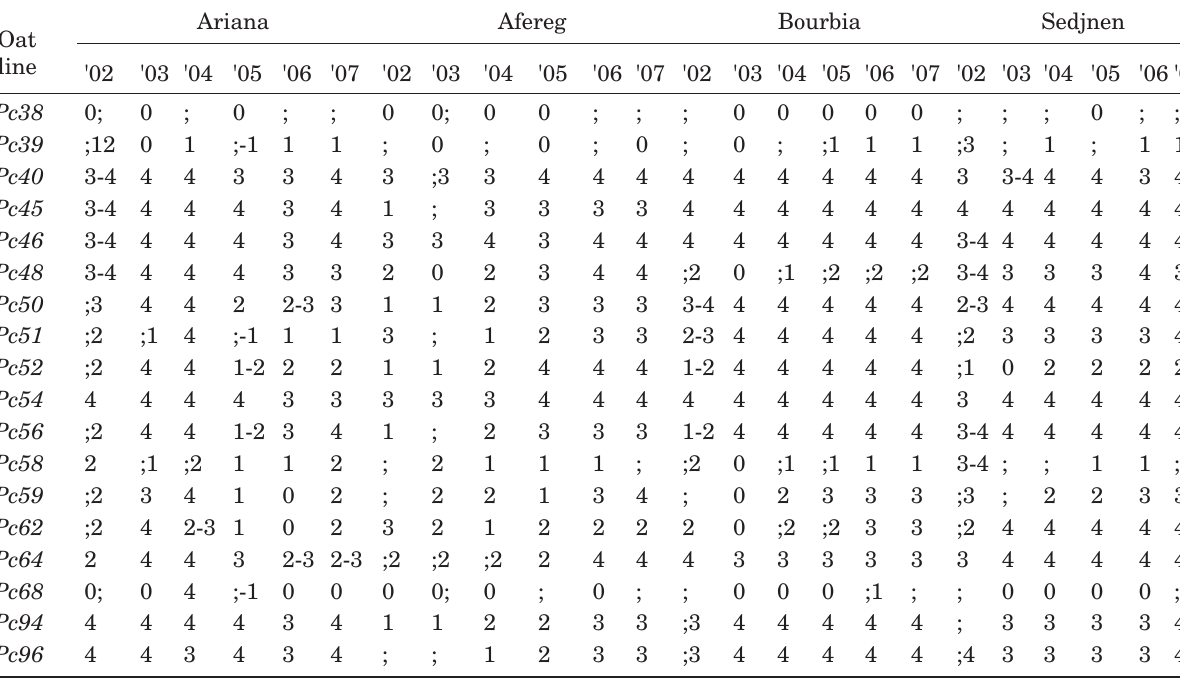
Table 1. Reaction a of the 18 oat lines to natural crown rust over 6 years, in Ariana, Afereg, Bourbia and Sedjnen. Ariana Afereg Bourbia